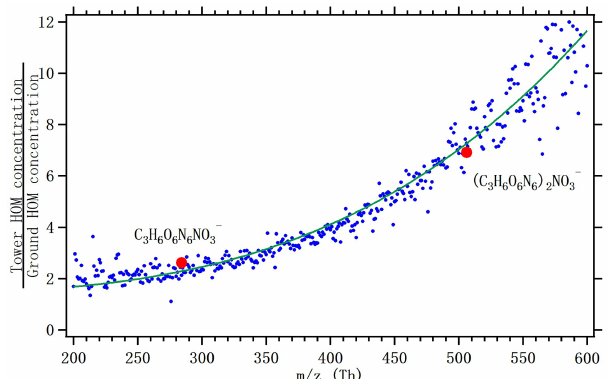
Figure 1. The relative transmission curve between the two CI-APi- TOF mass spectrometers, determined during a period of strong tur- bulent mixing. Intercomparison results using a permeation tube con- taining trinitrotriazinane (C 3 H 6 N 6 O 6 ) are shown in red circles. The fitted green line was used to scale the measured signals between the two instruments to match, in order to compare relative changes dur- ing times of limited vertical